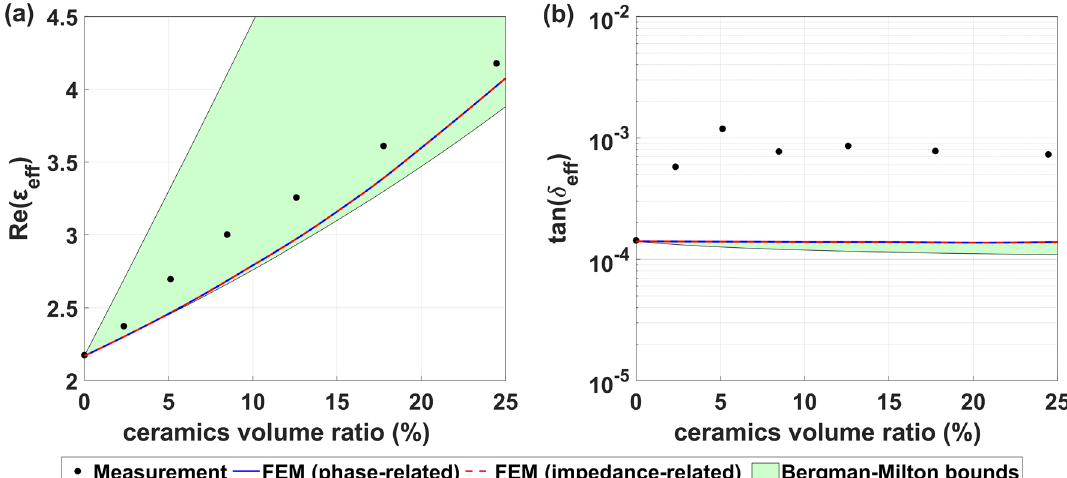
Figure 2. Correlation of the ceramic concentration on the composite ( a ) real dielectric constant and ( b ) loss tangent at the frequency of 5 GHz. Measurement, simulation results, and analytical Bergman-Milton bounds are